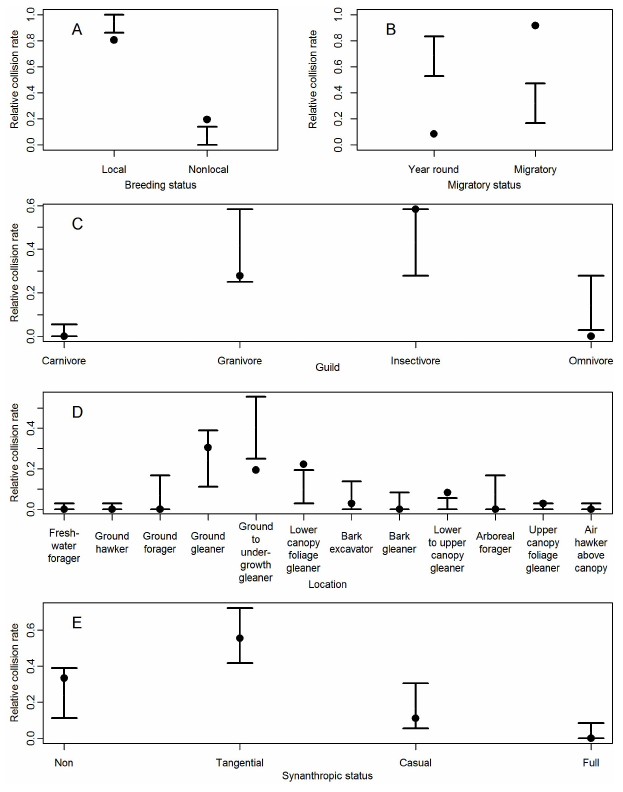
Fig. 4 . (A) Comparison of expected and observed collision rates for local and nonlocal breeders, as defined by Cook (2008). (B) Similar comparison for migratory status derived from weekly checklist (Cook 2008). (C) Confidence interval comparison based on González-Salazar et al.’s guild classification (2014). Nectarivores were absent from this comparison despite making up 14% (n = 5) of collisions at Duke in spring and fall 2015 because they were not observed during the campus point survey. (D) Finer guild comparison using González-Salazar et al.’s subclassification related to feeding location (2014). Guilds were loosely sorted left to right on foraging height. (E) Comparison of simulated versus observed collision rates among Johnston’s (2001) synanthropic